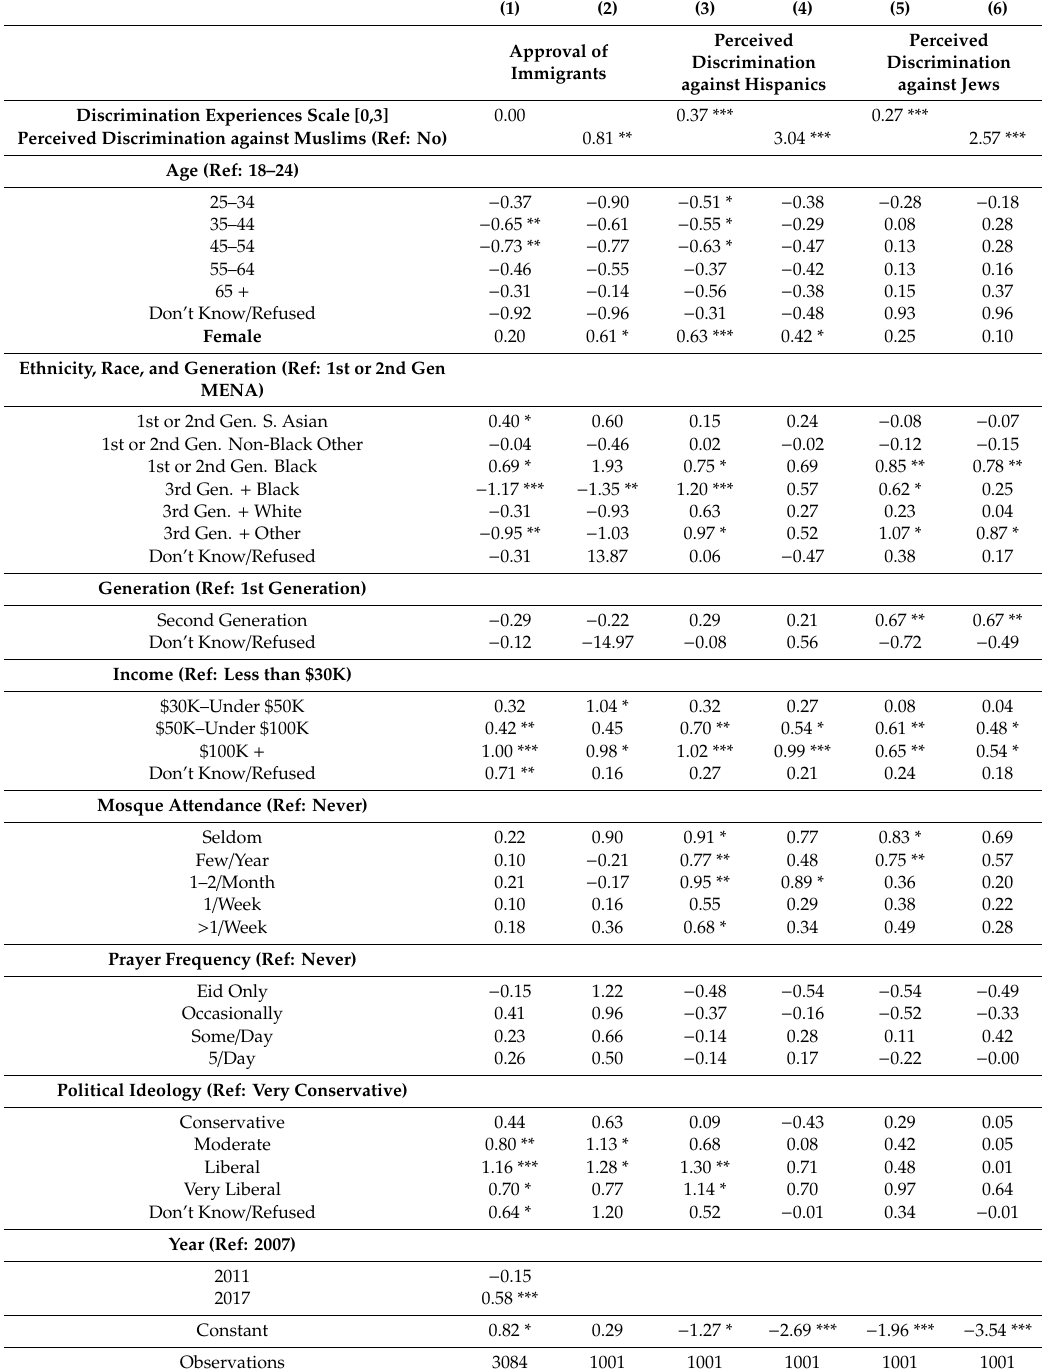
Table A6. Coe ffi cients from Logistic Regression Predicting Solidarity with Immigrants, Hispanics, and Jews Using Imputed